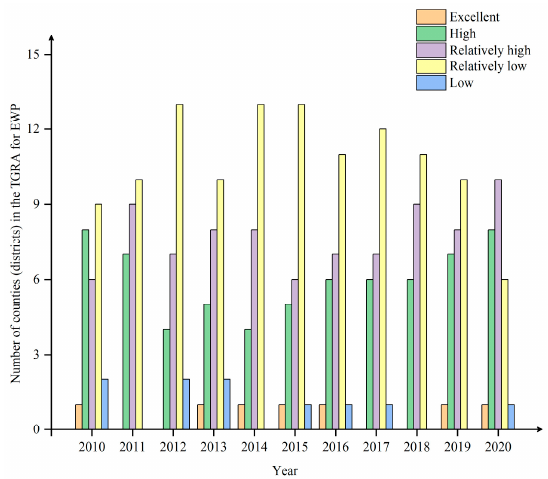
Figure 4. Number of EWPs in the TGRA by grade, 2010–2020. For comparison, the EWP of the TGRA in 2010, 2014, 2017, and 2020 was selected to plot the kernel density function in this study (Figure 5). The kernel curve moves to the right with the main peak and shows an overall upward trend, while the waveform shows a transition from a double peak to a single peak, indicating that the EWP of the TGRA is gradually improving and the polarization has weakened. In addition, the distribution curve indented from the right to the left side, and the double-tailed extension continued to become narrower, indicating that the internal variation in the TGRA was slowing down. Figure 5. The kernel density of EWP in the TGRA, 2010–2020. 4.2.2. Spatial Evolution Characteristics of the Overall Efficiency of EWP in the TGRA Regarding spatial distribution characteristics (Figure 6), the EWP in the study area generally showed a distribution pattern of high in the east and low in the west, with higher performance values in CEAC and HRA and lower performance values in CUAC and NAC. The top five regions in terms of mean value are mainly Wushan County (1.013), Yuzhong District (0.957), Wuxi County (0.923), Yunyang County (0.906), and Badong County (0.857), of which four counties (districts) are located in the eastern region. The lowest mean values are in Changshou District and Xingshan County, with values of 0.446 and 0.439, respectively, in low-efficiency areas. The reason may be that Wushan County, Wuxi County, Yunyang County, and Badong County have relatively backward industrial conditions, less energy consumption, and environmental pollution, as well as better eco- logical resource endowment and high efficiency of EWP. Yuzhong District, on the other